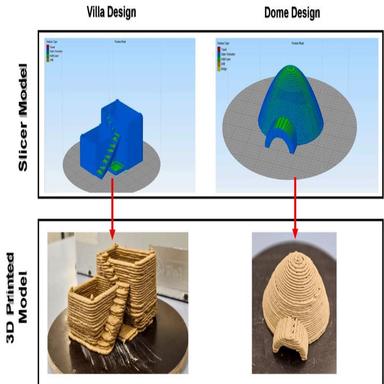
3DP structure of villa pot and dome models.